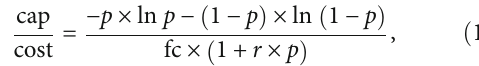
network. The color of the small rectangle indicates the